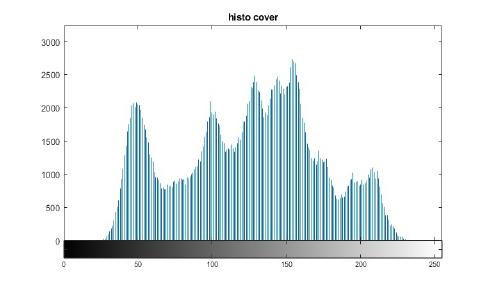
Figure 10: Cover image